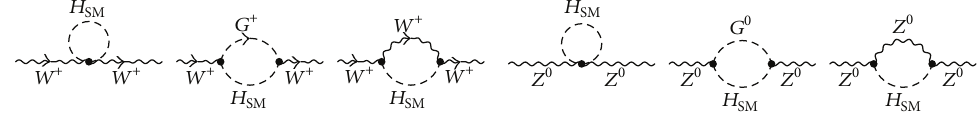
Figure 3: Feynman diagrams for the self-energies Π SM 𝑊𝑊 (𝑠) and Π SM 𝑍𝑍 (𝑠) which contribute to the oblique parameters. All other diagrams vanish, respectively, cancel with the corresponding diagrams in Π NMSSM 𝑊𝑊 (𝑠) and Π NMSSM 𝑍𝑍 (𝑠)